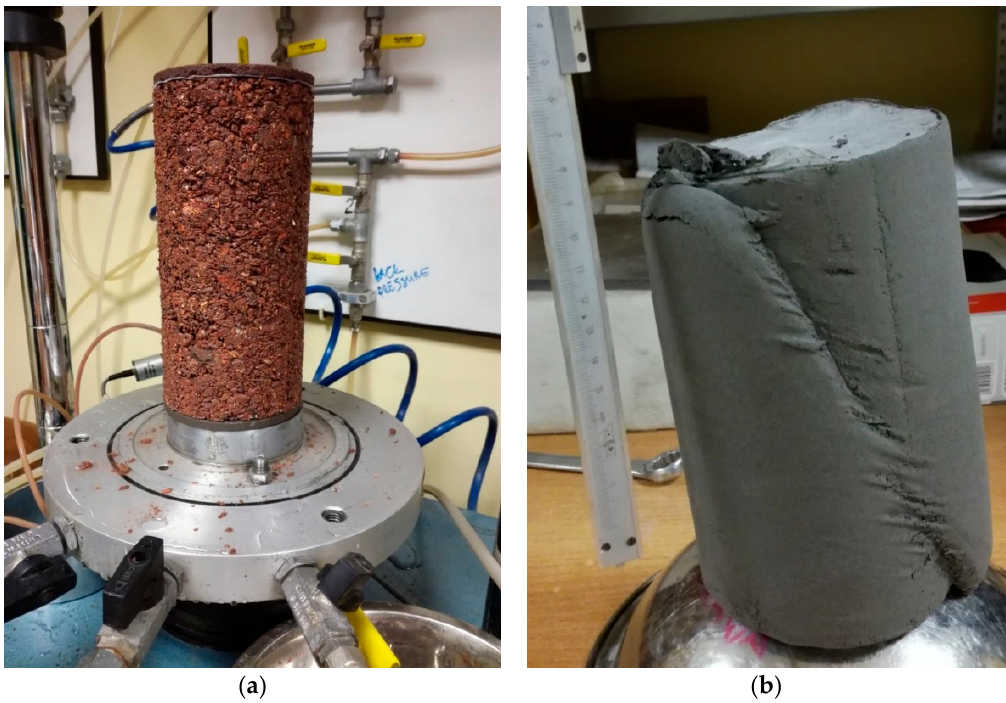
Figure 1. A formed sample of burnt coal waste ( a ) and a sample of fly ash after the test with a visible shear surface ( b ) (photo by A. Gruchot).